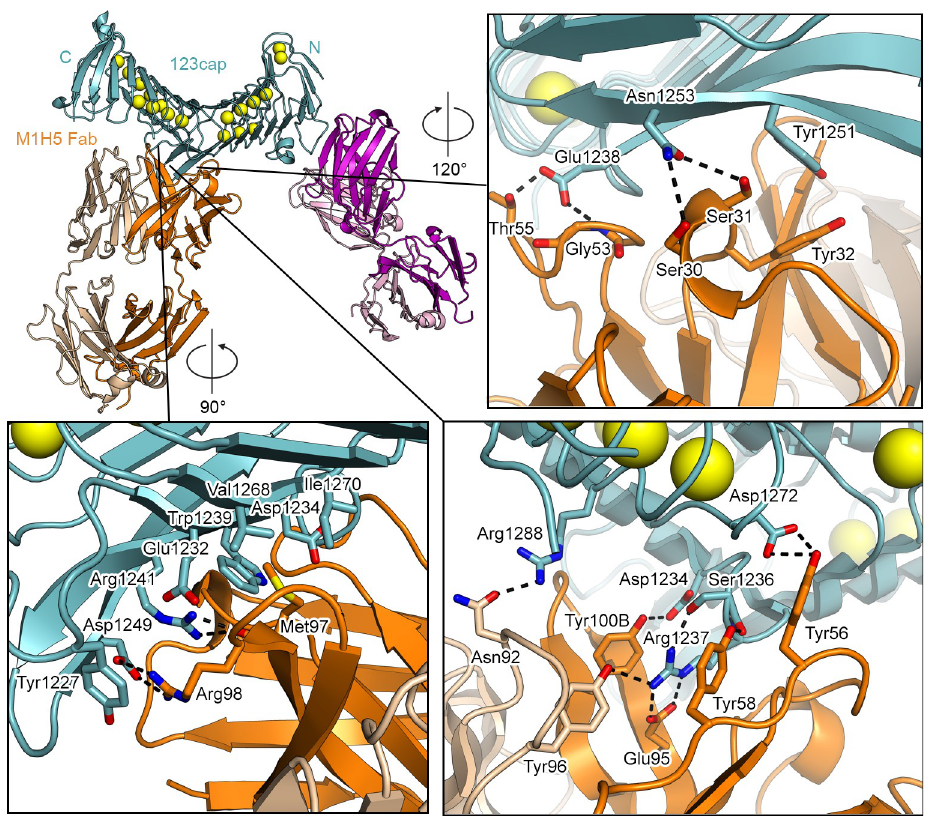
Fig 5. Interactions formed by M1H5 with linker 2 of the RTX domain. Structures are shown as ribbon representation with select residues shown as sticks, with nitrogens colored blue, oxygens colored red, and sulfur colored yellow. Calcium is represented as yellow